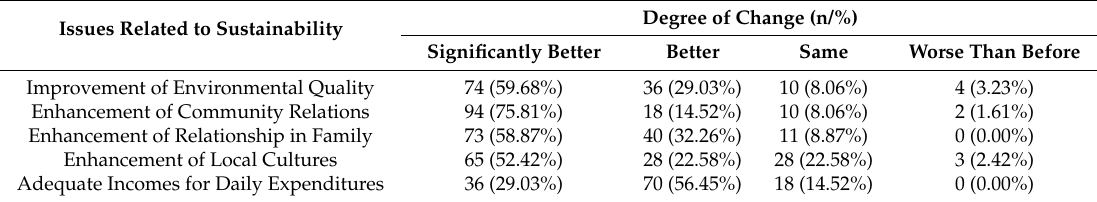
Table 3. Individuals’ perception of economic, social, and environmental